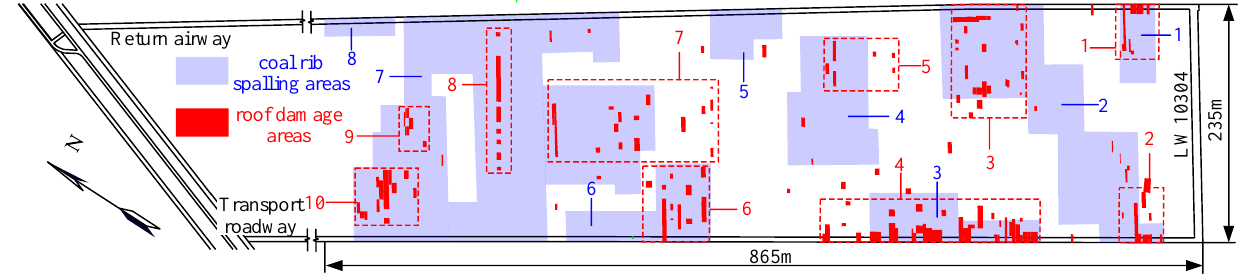
Figure 2. X2 borehole histogram.